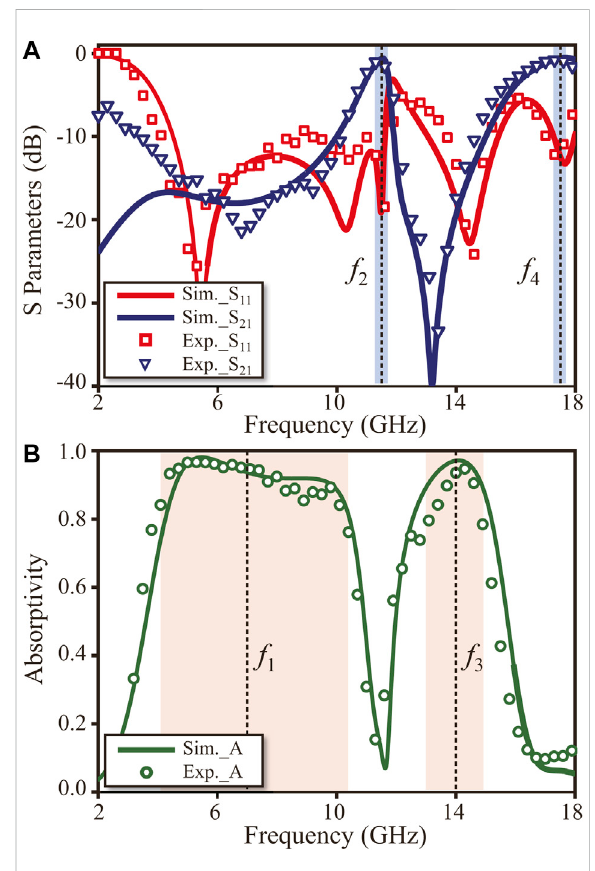
Experimental spectra (open symbols) and numerical spectra (solid curves) of the fabricated prototype with (A) transmission/ re fl ection (blue/red), and (B) absorptivity